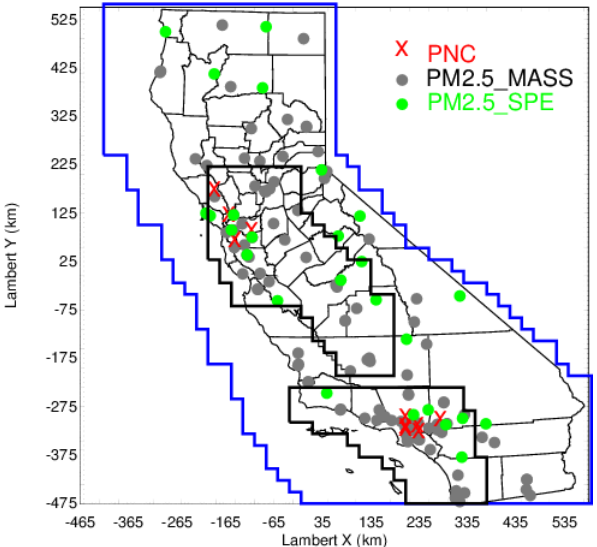
Figure 2. Modeling domains. Blue lines outline the CA_24km do- main; black lines outline the SoCAB_4km (bottom) and SJV_4km domains (top). Red crosses represent 10 N x sites: four sites op- erated by staff at the Bay Area Air Quality Management District (BAAQMD) and six sites from the Multiple Air Toxics Exposure Study IV (MATES IV). Detailed location information for the N x sites is listed in Table S3. Green dots represent BAAQMD PM 2 . 5 speciation network sites and the Interagency Monitoring of Pro- tected Visual Environments (IMPROVE) sites; gray dots represent the PM 2 . 5 federal reference method (FRM)